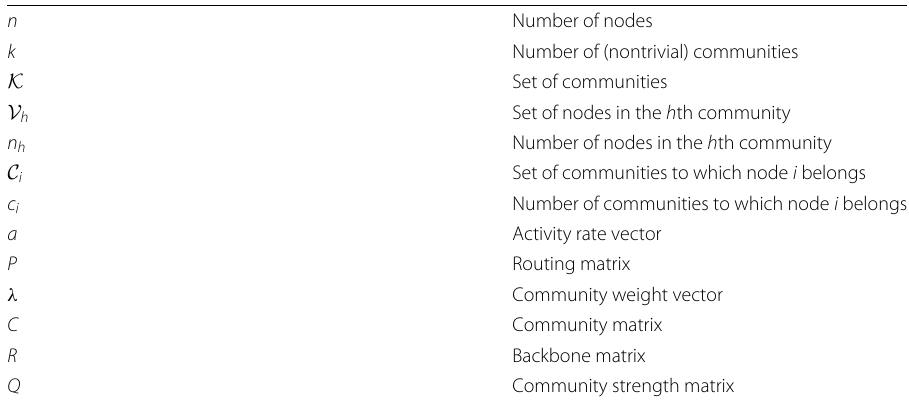
Table 1 Parameters that characterize a rADN